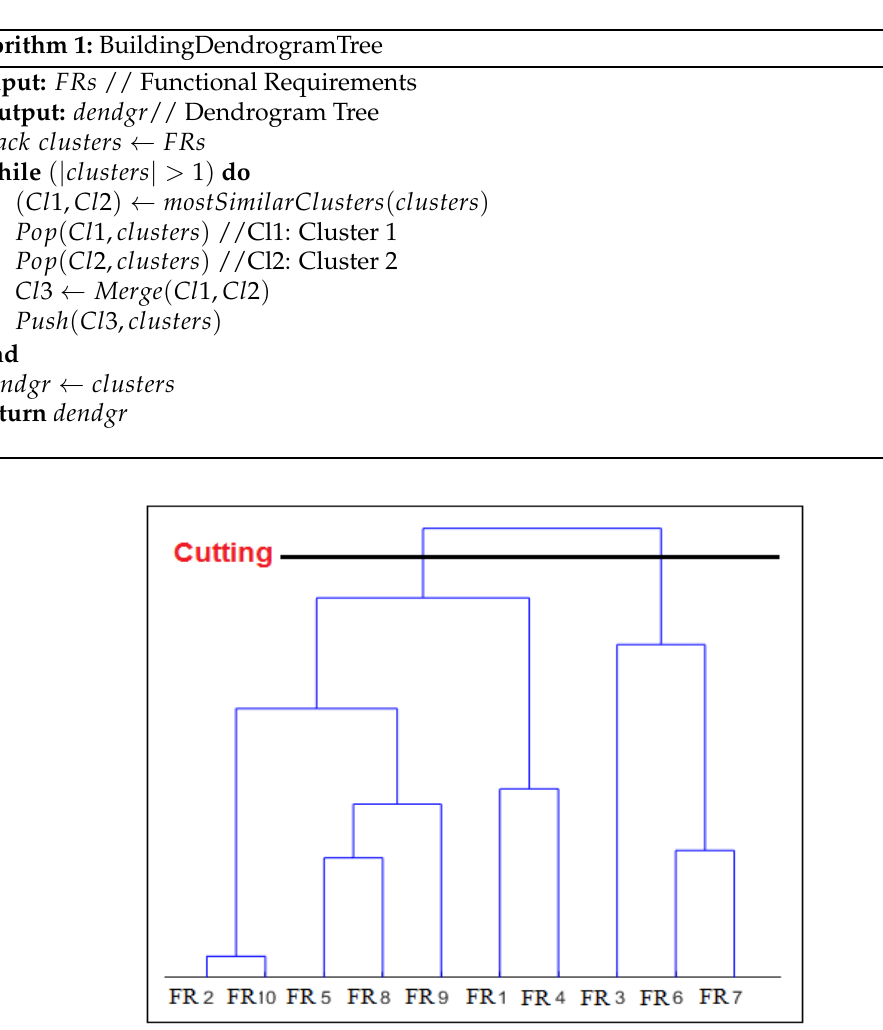
Figure 3. A graphical representation of a dendrogram